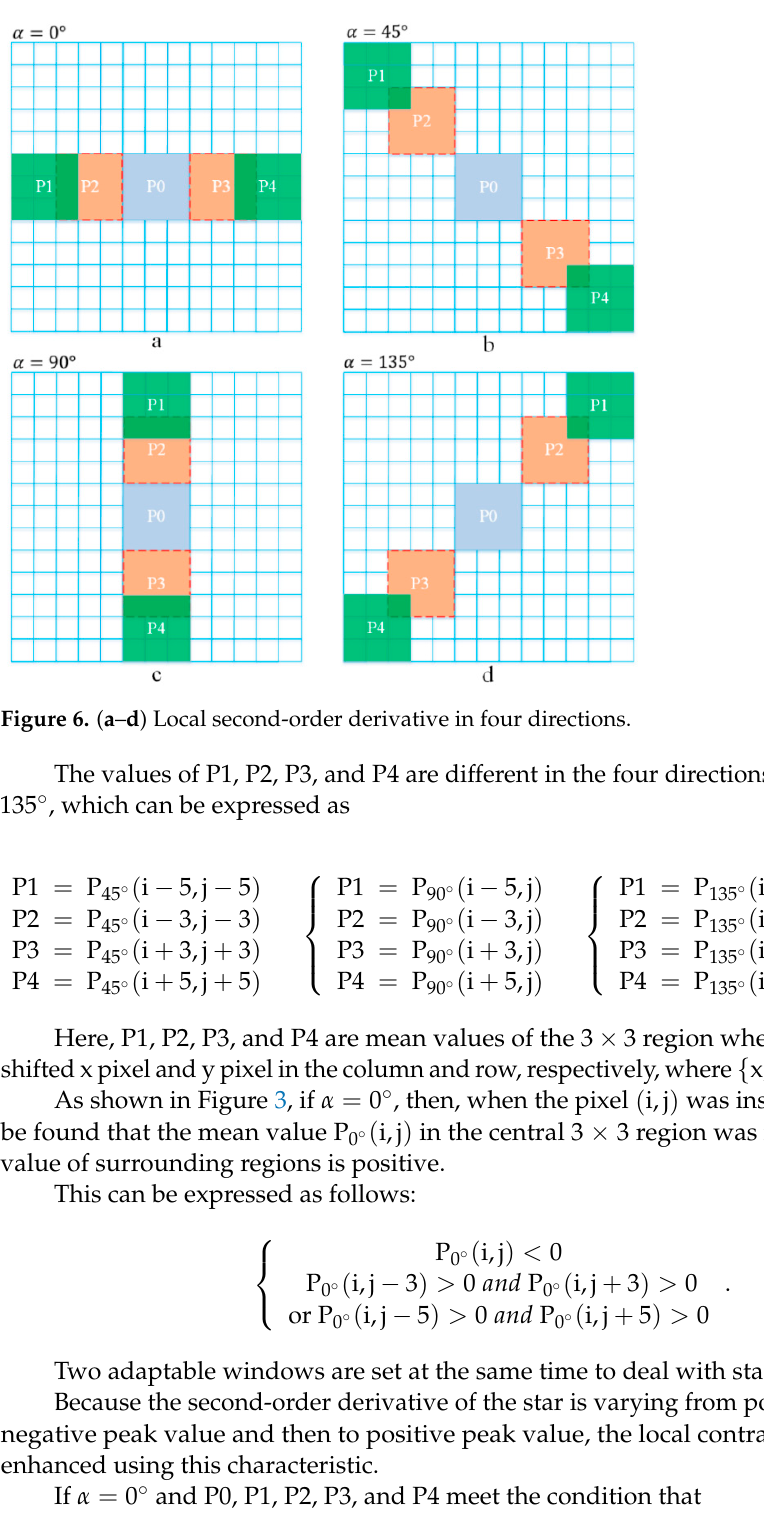
patch is 3 × 3. Here, P0 represents the mean value of the second-order derivative in the